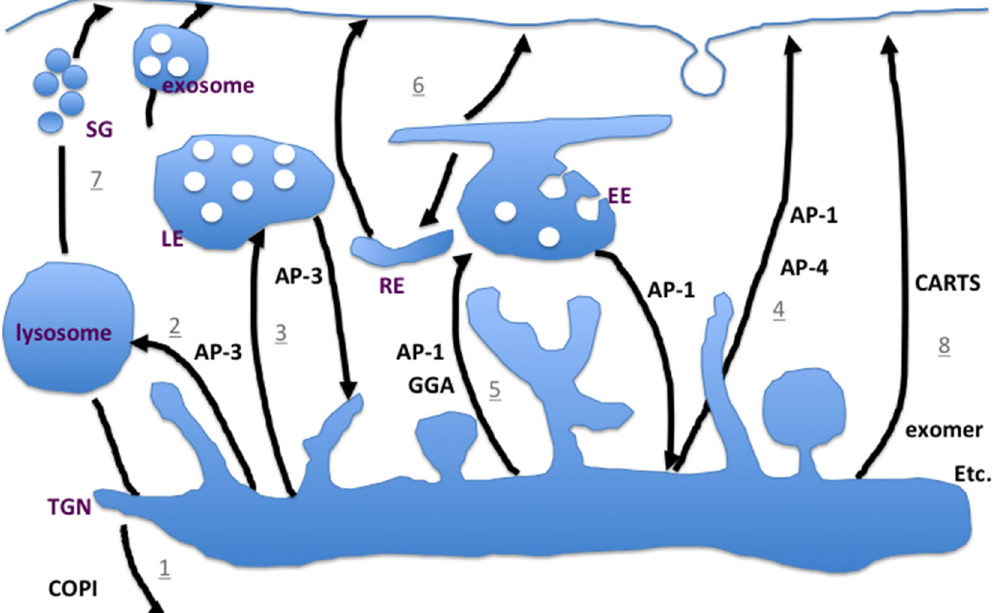
Figure 2. Schematic drawing of the exit pathways from the trans -Golgi network (TGN). For more detailed information, see text. SG; secretory granules, EE; early endosomes, LE; late endosomes, RE; recycling endosomes. The numbers refer to the TGN-plasma membrane pathways mentioned in the